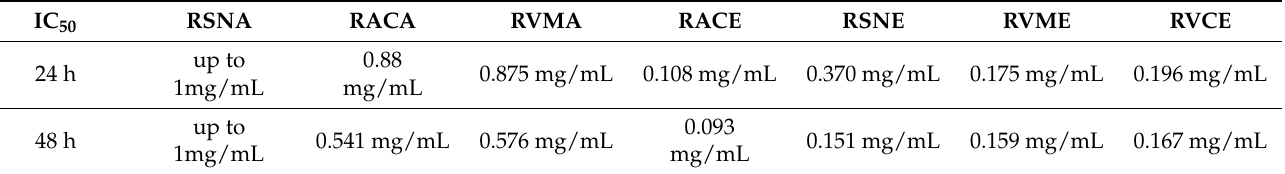
Table 5. The IC 50 doses of anthocyanins on DLD1 Cells.